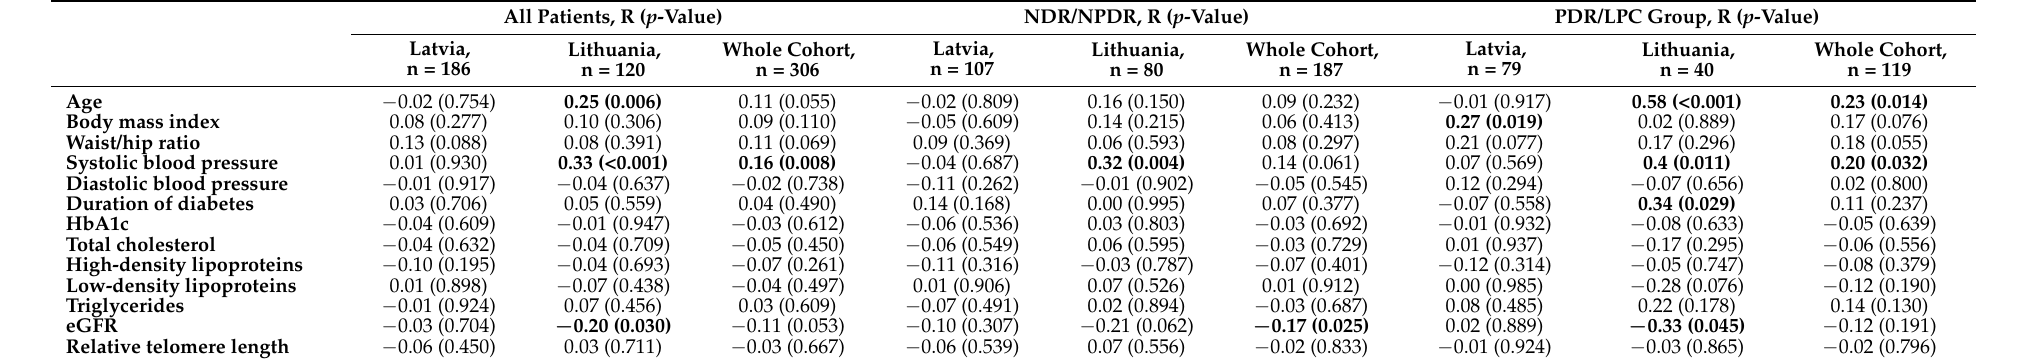
Table 4. Correlations between serum proteasome concentrations and clinical